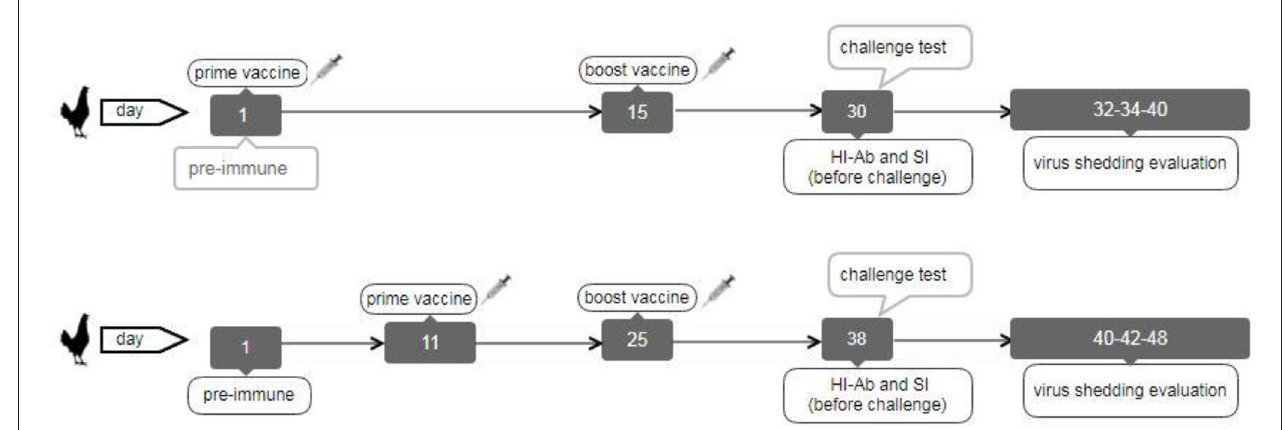
FIGURE 1 | The broiler chicken vaccination diagram in early (top) and late (down)